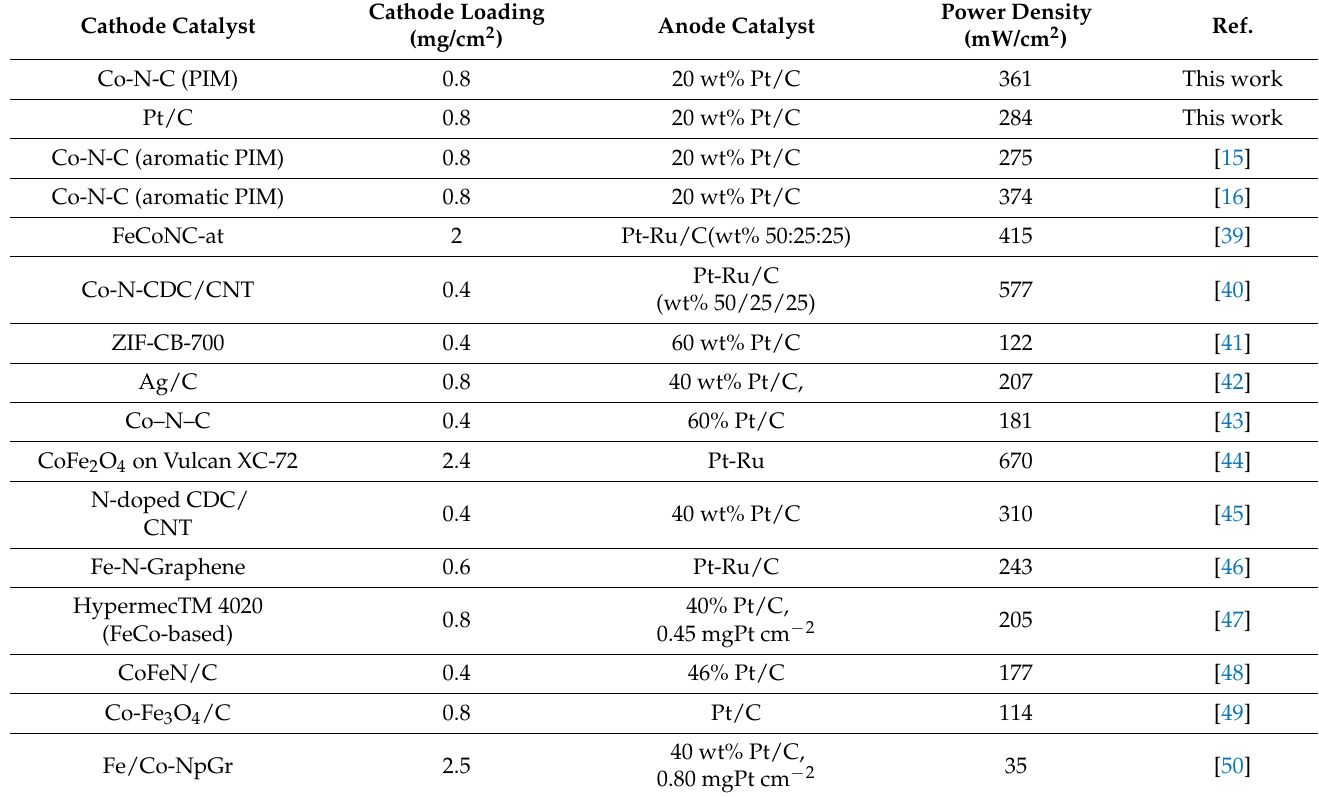
Table 5. Performance of various non-precious metal cathode catalysts of